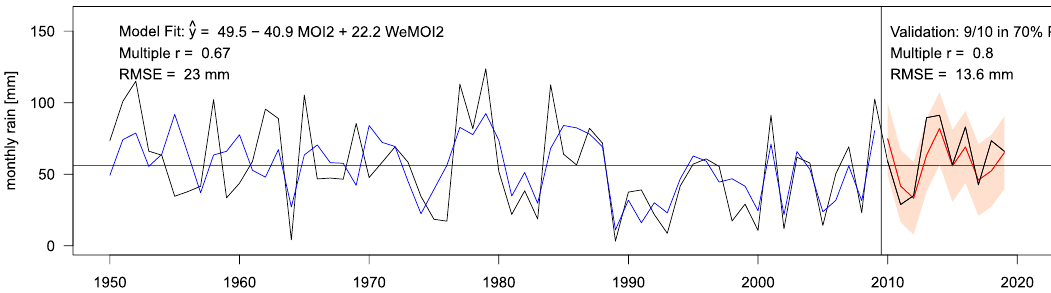
Figure 6. Best subset regression and validation for January rainfall in Slovenia. The black line represents the actual rainfall 1950–2019—average marked by the horizontal. In the left part of the graph (1950–2009), the blue (cid:31) Y line shows the rainfall as modelled by the regression equation in row 1 of Table 2: Other atmospheric indices beside MOI2 and WeMOI were not relevant for this example. The right part illustrates the validation in the years 2010–2019 with the red line as the predicted rainfall that resulted from inserting the MOI2 and WeMOI values observed in 2010–2019 into the regression equation from 1950 to 2009. The pink area is the 70% confidence interval of prediction (see Methods below and Statistical Methods in Suppl. ch.